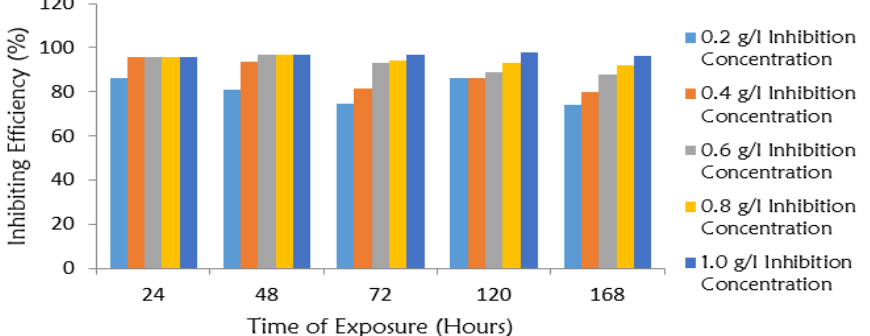
Figure 10: The percentage inhibition efficiency of Prosopis Africana seed extract at different